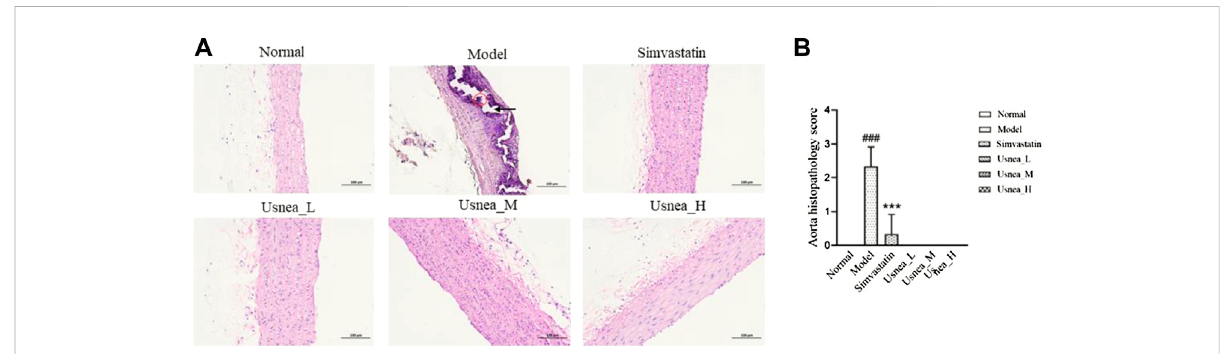
FIGURE 2 Pathological status of the aorta in each group of rats (200 × ). (A) In AS rats, some endothelial cells were missing in the aortic tissue, the endothelium was damaged (black arrow), and the thickness of the middle membrane was uneven; moreover, the nuclei of the smooth muscle cells were irregularly shaped and large calcium salt deposits were visible (red circle). Results are expressed as the mean ± SD ( n = 6 per group). (B) Aorta histopathological score, n = 3. Compared with the normal group, ### p < 0.001; compared with the model group, ** p < 0.01, *** p < 0.001.